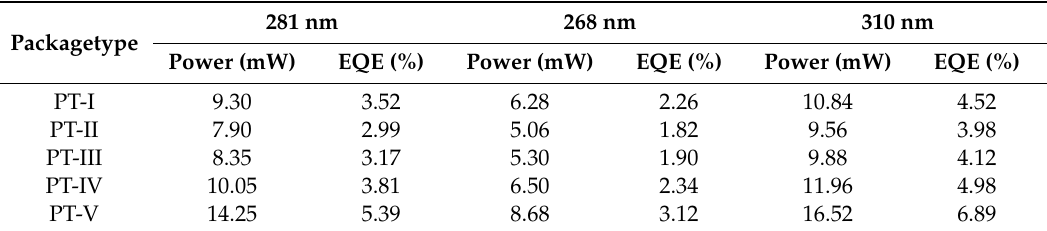
Table 2. Optical power and EQE results for di ff erent types and di ff erent wavelength DUV LEDs at 60